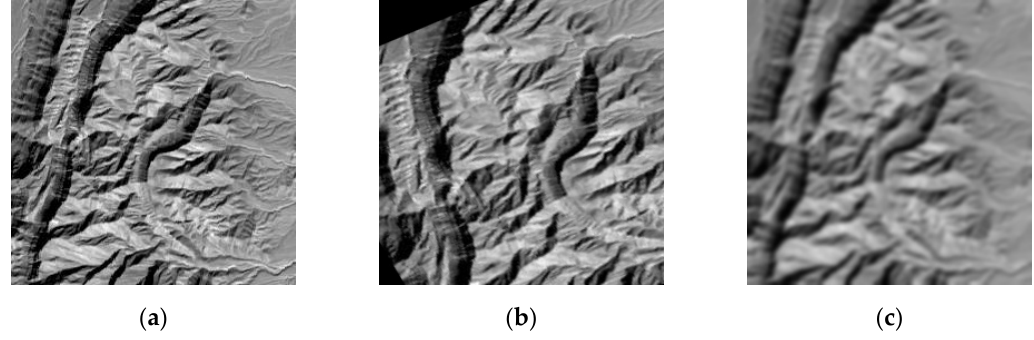
Figure 2. A single channel remote sensing image of mountain. ( a ) Original image, ( b ) same view, distorted by warp affine, and ( c ) same view, distorted by Gaussian blur. Image quality assessment (IQA) scores between ( a ) and ( b ): mean square error (MSE) = 0.091, structural similarity (SSIM) = 0.056 and learned perceptual image patch similarity (LPIPS) = 0.628. IQA scores between ( a ) and ( c ): MSE = 0.009, SSIM = 0.537 and LPIPS = 0.661. (Note that, unlike MSE and LPIPS, larger values of SSIM indicate better quality.).